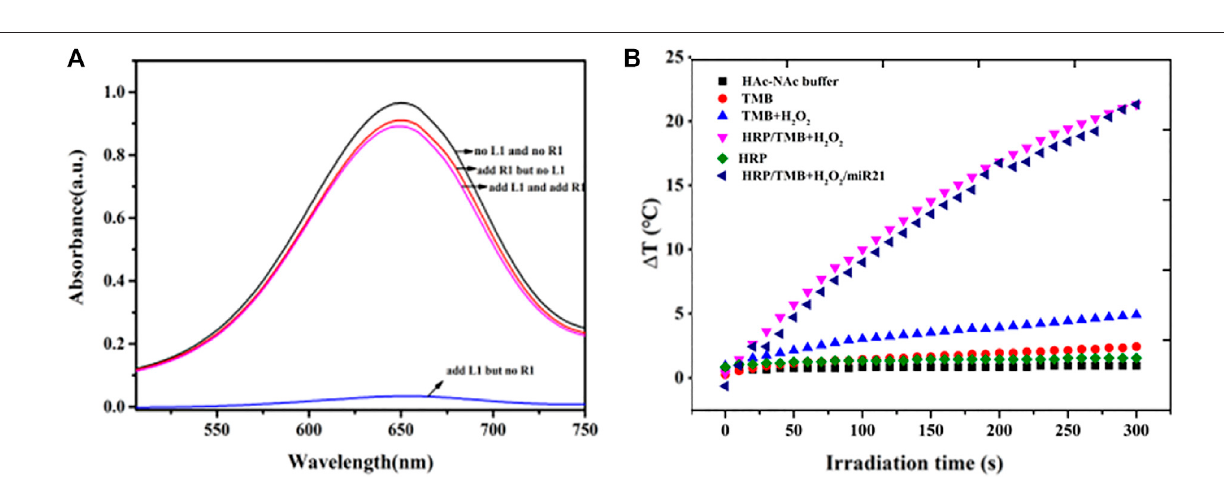
Frontiers in Bioengineering and Biotechnology |